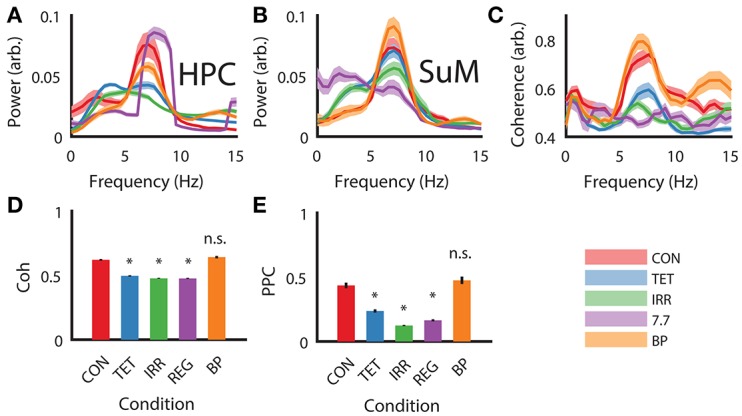
Power spectral density, coherence and PPC comparisons across different experimental conditions. (A) Group HPC PSD mirrors time-frequency representation presented in Figure 1—theta power is comparable between CON, REG, and BP conditions and higher than TET and IRR conditions, with REG theta frequency shifting to imposed 7.7 Hz. (B) Group SuM PSD showed minimal changes in PSD across the conditions, with the exception of REG condition, where theta power was greatly attenuated and slower oscillations predominate. (C) Theta coherence magnitude is similar between BP and CON, but low for TET, IRR and REG, with the latter having the lowest coherence. (D) Averaged theta band (5–12 Hz) coherence as in (C). (E) Averaged theta (5–12 Hz) PPC differences across conditions are consistent with ordinary coherences but have a larger dynamic range. Asterisks indicate statistical significant, post-hoc differences compared to the CON condition, p < 0.001. CON, control; TET, tetracaine; IRR, irregular; REG, regular at 7.7 Hz; BP, by-pass; HPC, hippocampus; SuM, supramammillary nucleus; PSD, power spectral density; PPC, pairwise-phase consistency.